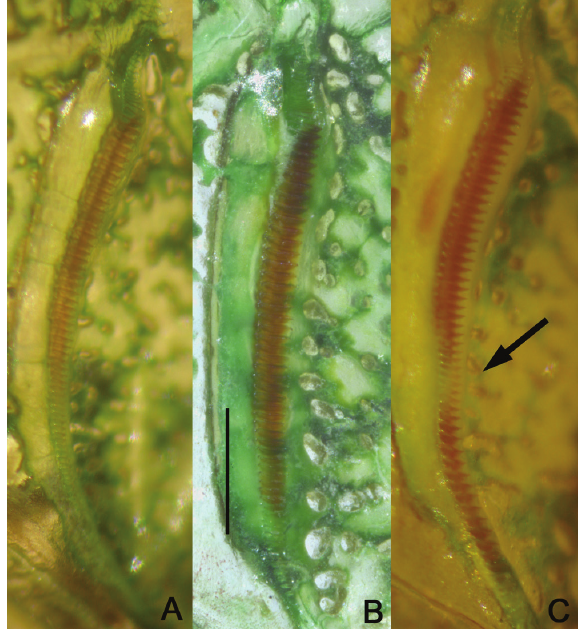
Figure 4. Stridulatory files of male G. maculata ( A ), G. immac- ulata ( B ) and G. helleri sp. n. ( C ). The arrow points a the dis- continuity (elevation midway) typical for G. helleri sp. n. Scale bar 0.5 mm.